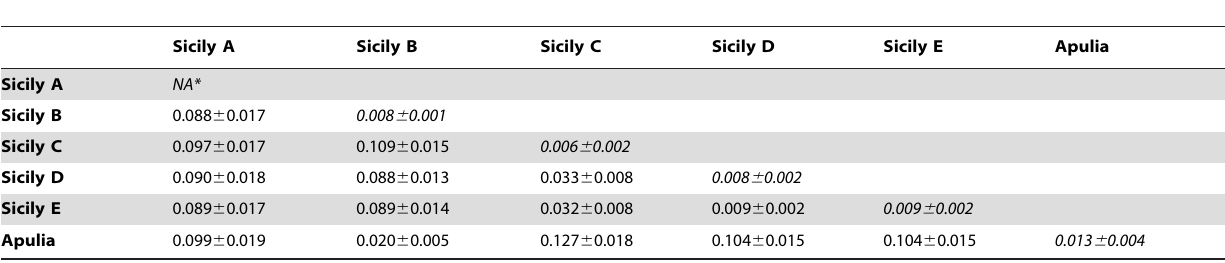
Table 2. Nucleotide diversity of p20 gene of CTV isolates from Italy corresponding to different introductions.